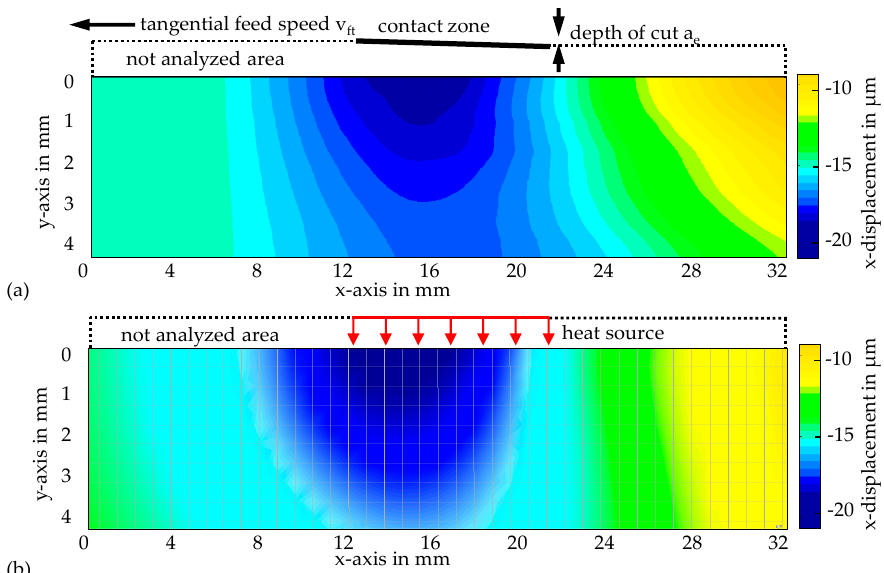
Figure 6. Total displacements during the process in feed speed direction: ( a ) measured with the speckle photography; ( b ) simulated.